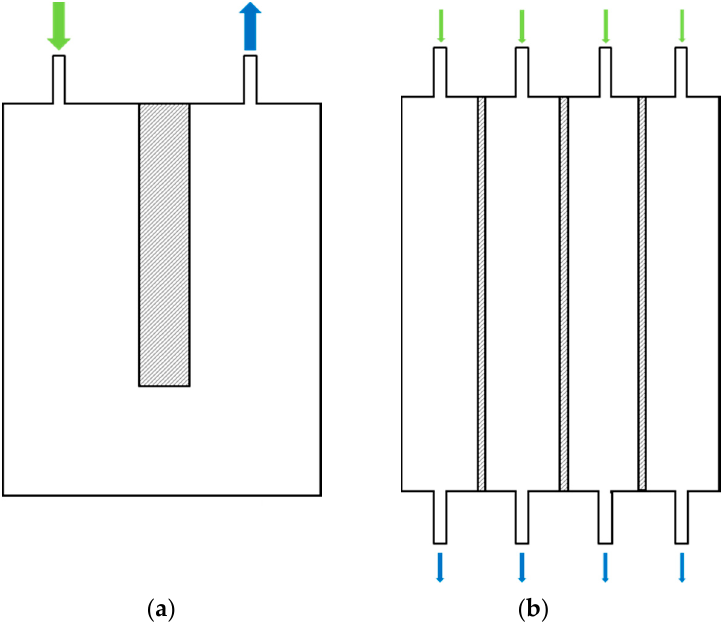
Figure 2. U-shape ( a , b ) straight (draw circulation) channels submerged FO plate designs. Draw inlet in green, draw outlet in blue.